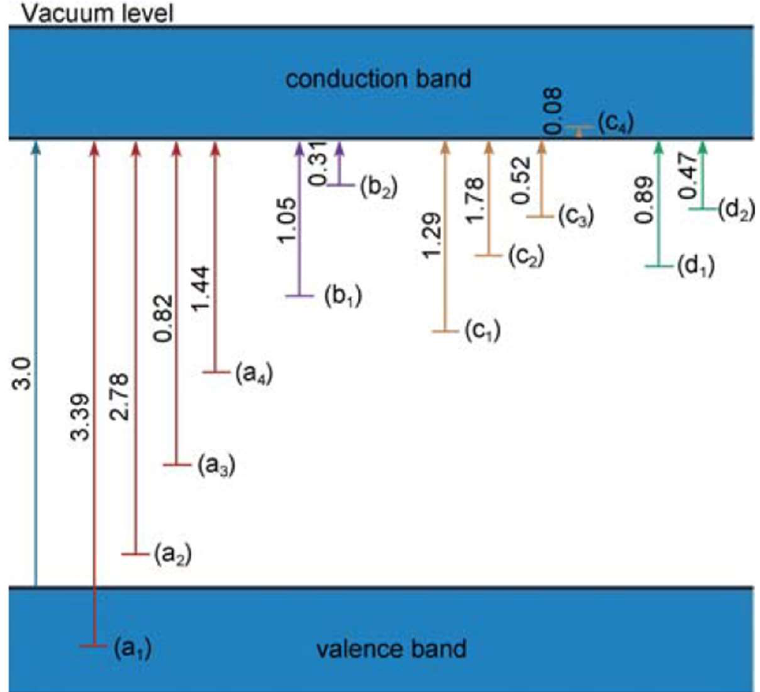
Figure 11. Various defect levels of Titania. The numbered letters a 1 , a 2 , a 3 , a 4 , b 1 , b 2 , c 1 , c 2 , c 3 , c 4, d 1 and d 2 represent the defect levels V Tix / V (cid:2904)(cid:2919) ● , V (cid:2904)(cid:2919) ● / V (cid:2904)(cid:2919) ●● , V (cid:2904)(cid:2919) ●● / V (cid:2904)(cid:2919) ●●● , V (cid:2904)(cid:2919) ●●● / V (cid:2904)(cid:2919) ●●●● , O (cid:2925)(cid:4593) / O (cid:2919)(cid:4593)(cid:4593) , O (cid:2925)(cid:2934) / O (cid:2919)(cid:4593) , Ti (cid:2919) ●●● /